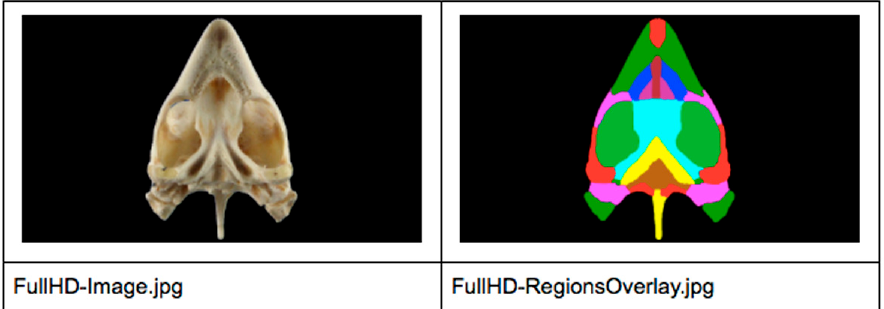
Figure 1. Representative image segmented using the ITK-SNAP software application is shown.